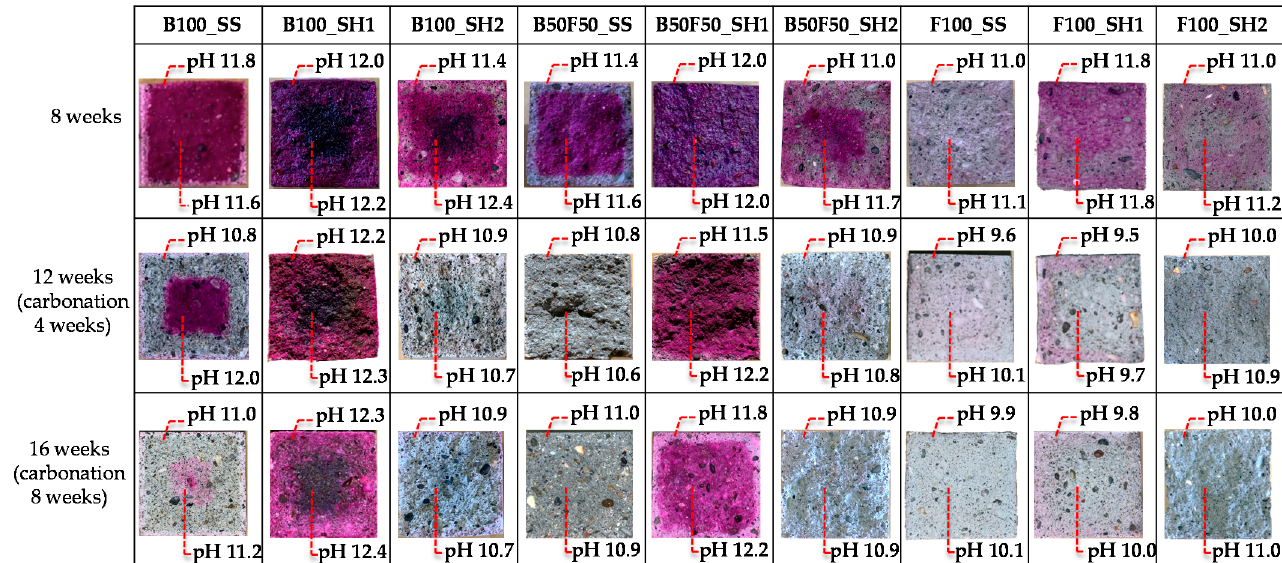
Figure 15. Changes in the colored areas of the mortar specimens after spraying with phenolphthalein and the corresponding changes in the pH values.